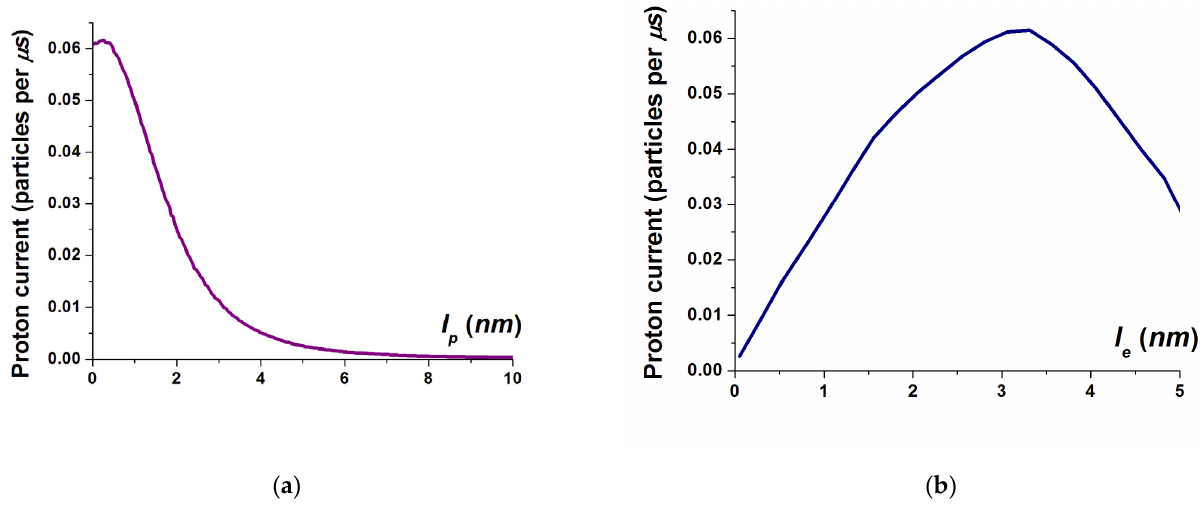
Figure 6. Dependencies of proton-pumping current on the separation of equilibrium piston position with respect to ( a ) proton site M and ( b ) electron site C .